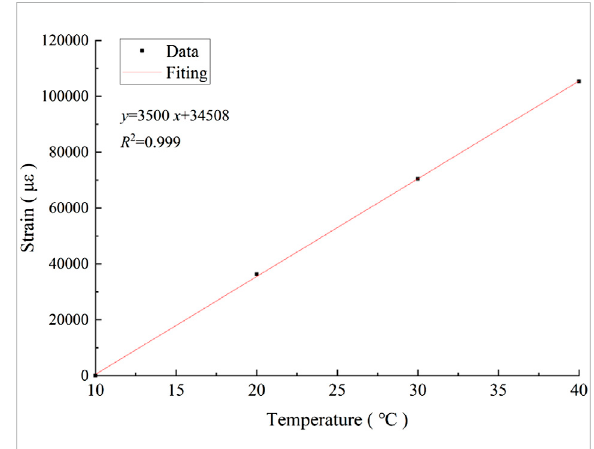
FIGURE 7 Fitting of temperature vs. thermal output of a thermosensor.